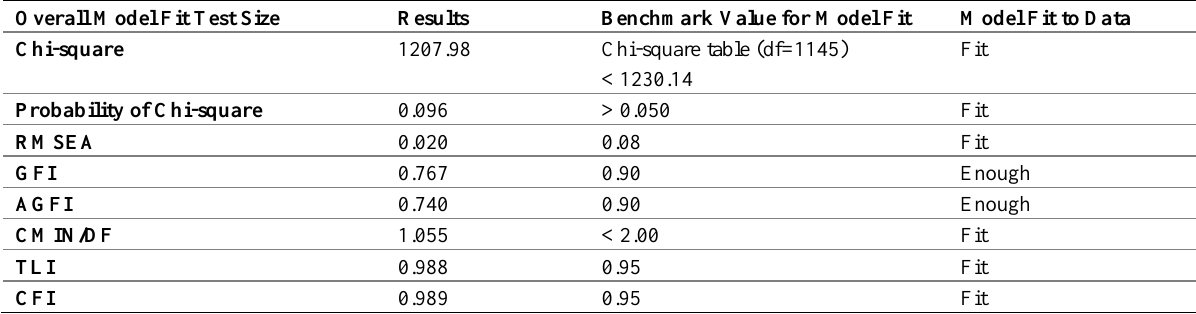
Table 1: Table of model fit